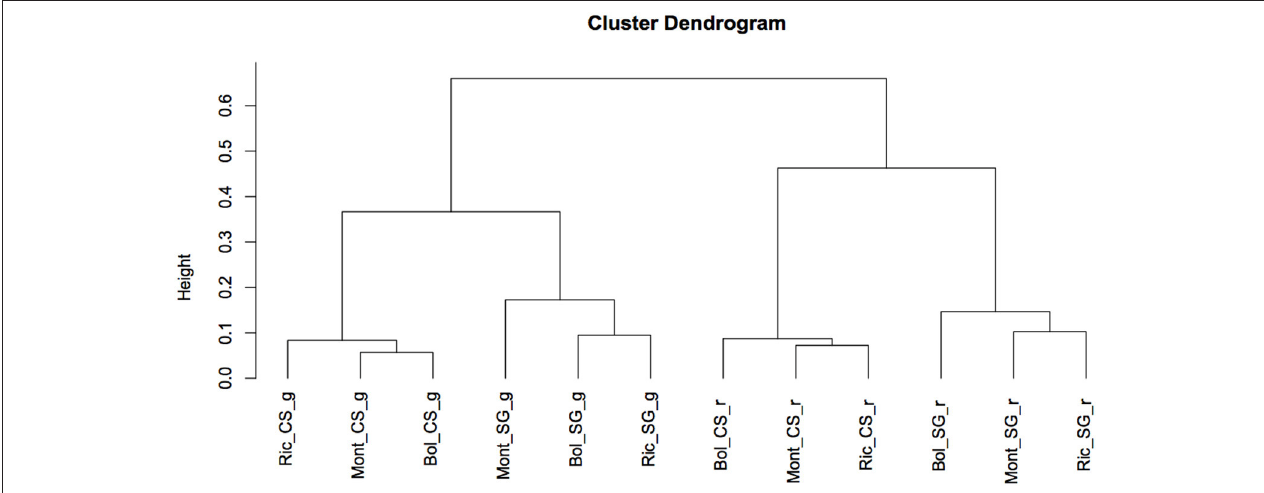
FIGURE 4 | Cluster dendrogram showing global relationships of small RNA-producing loci in 2 different grapevine cultivars, collected in different vineyards and developmental stages. The Pearson correlation coefficients, calculated based on sum of HNA of small RNAs mapping to each loci, were converted into distance coefficients to define the height of the dendrogram. Bol, Bolgheri; Mont, Montalcino; Ric, Riccione; CS, Cabernet Sauvignon; SG, Sangiovese; g, green; r, ripened. Green corresponds to bunch closure and ripened corresponds to 19 ◦ Brix developmental